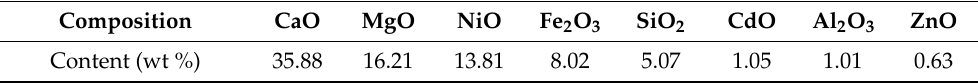
Table 1. The main components of the nickel-containing